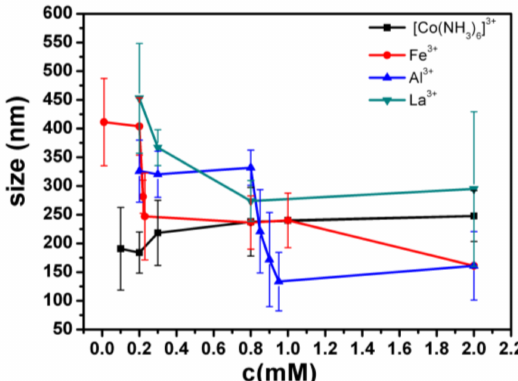
Figure 4. The size of DNA as a function of the concentration of different trivalent metal ions. The error of particle sizes is standard deviation, obtained from the CONTIN analysis software from DLS. In the measurement of particle size, there is only one peak at all different conditions for most cases, but two peaks in some fewer cases (<5%). We used only the one peak data for spread calculation.